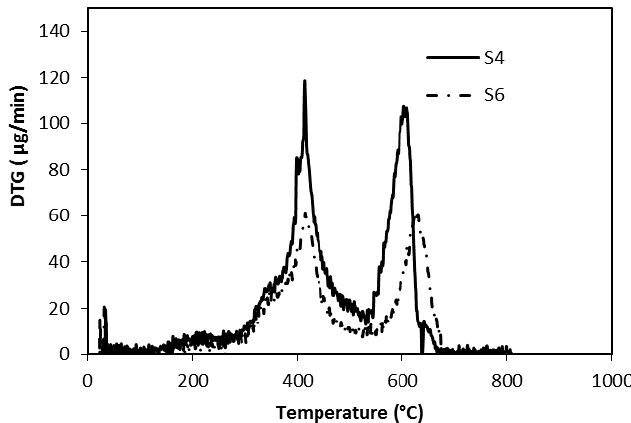
Figure 5. Comparison of the curves describing the degradation rates of the S4 and S6 samples (5.0 mg and 2.5 mg samples, respectively; not normalized by weight).